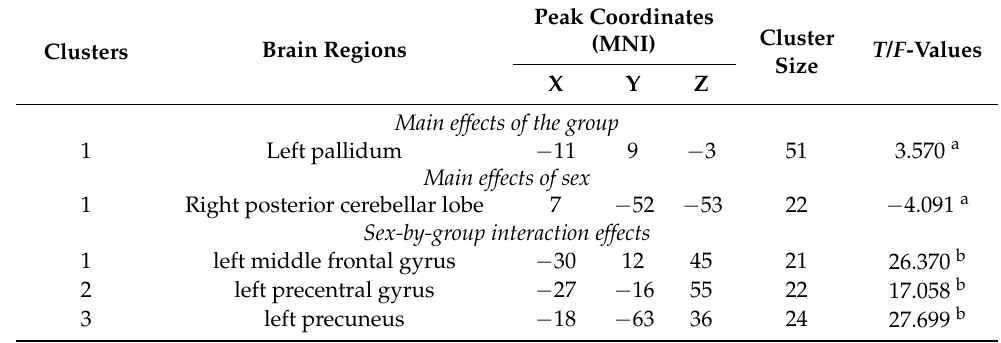
Table 2. Brain areas with significant ALFF differences among the four